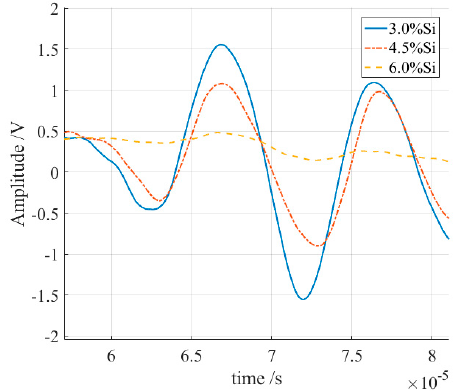
Figure 9. The S0 Lamb waves of the samples with different silicon contents.